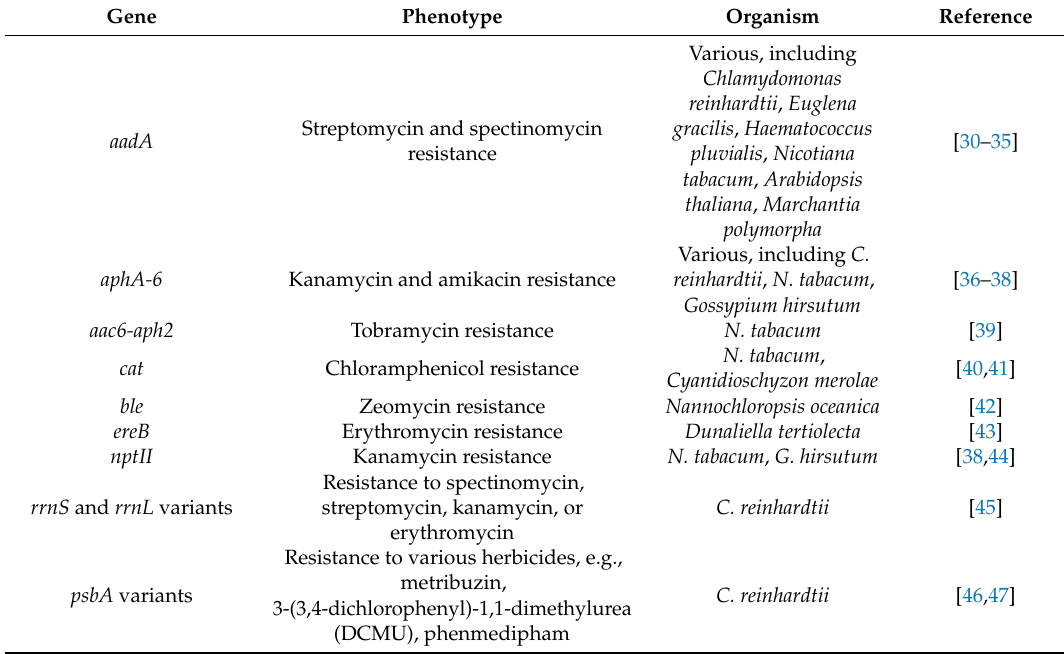
Table 1. Selectable markers for chloroplast engineering. Markers discussed in this review are summarized. Details include the conferred phenotype, and examples of organisms for which the use of the marker has been